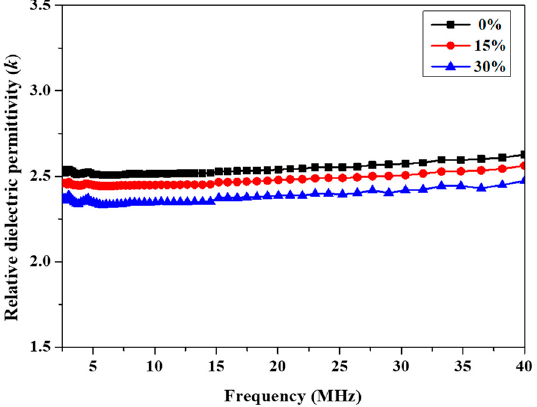
Figure 5. Frequency dependence of relative dielectric permittivity of cured P(4-MB-co-1-MP) and P(4-MB-co-1-MP)/BCB-POSS resins. P(4-MB-co-1-MP)/BCB-POSS